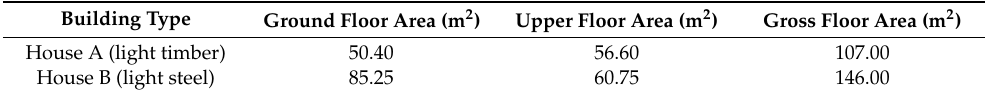
Table 1. Area of the buildings.